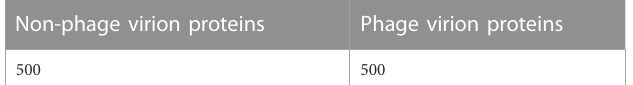
TABLE 1 The information of